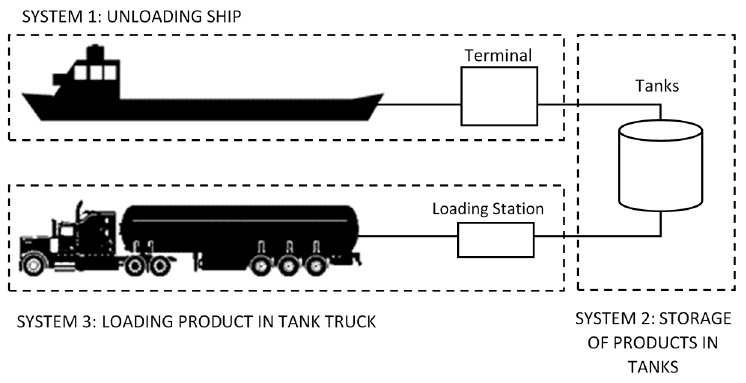
Figure 3. Three areas of activity.